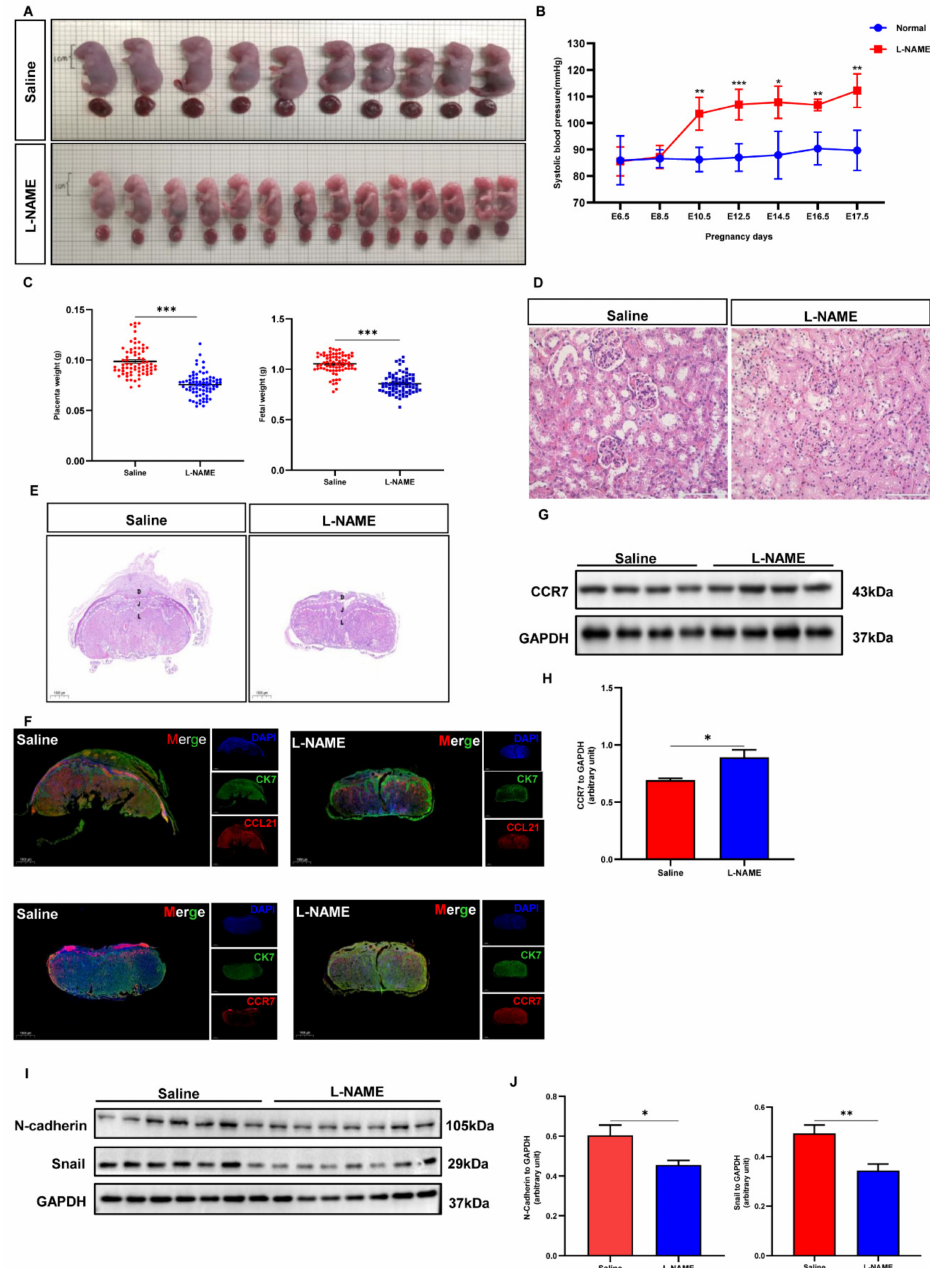
Figure 8. Altered expression of CCL21, CCR7, and EMT biomarkers in mice with L-NAME-induced PE model. ( A ) Representative images of the fetuses of the saline group and the L-NAME group. Scale bar-1 cm. ( B ) Systolic blood pressure of pregnant mice in the saline group and the L-NAME group ( n = 6). ( C ) The weights of the 75 embryos and 70 placentas from 6 dams in the saline group, and the 73 embryos and 73 placentas from 6 dams in the L-NAME group were measured. ( D , E ) Hematoxylin eosin-stained maternal kidney and placenta sections of saline- or L-NAME-treated mice at E17.5d. Scale bar-100 µ m; 1000 µ m. Abbreviations are as follows: D, decidual; J, junction zone; L, labyrinth. ( F ) Immunofluorescence of CCL21 and CCR7 in the mouse placental tissues in the L-NAME group and the saline group at E17.5d. Here, CK7 is indicated by green signals; CCL21 and CCR7 are indicated by red signals. Scale bar-1000 µ m. ( G – J ) Western blotting analysis of CCR7 and EMT biomarkers in placenta collected from the saline group and the L-NAME group at E17.5d and quantification (Supplementary File S1); * p < 0.05, ** p < 0.01, *** p <